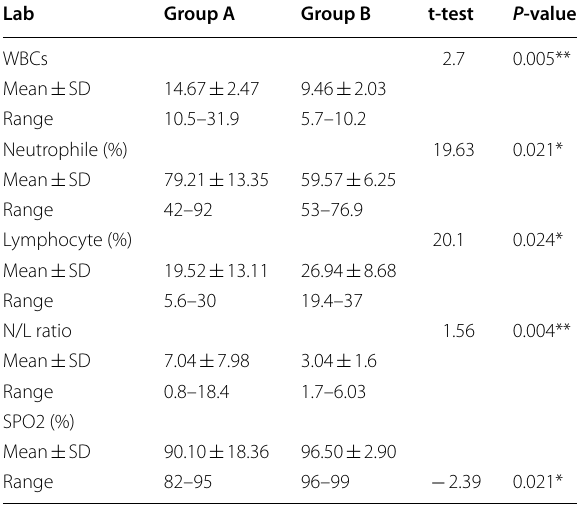
Table 2 Laboratory investigations in the studied